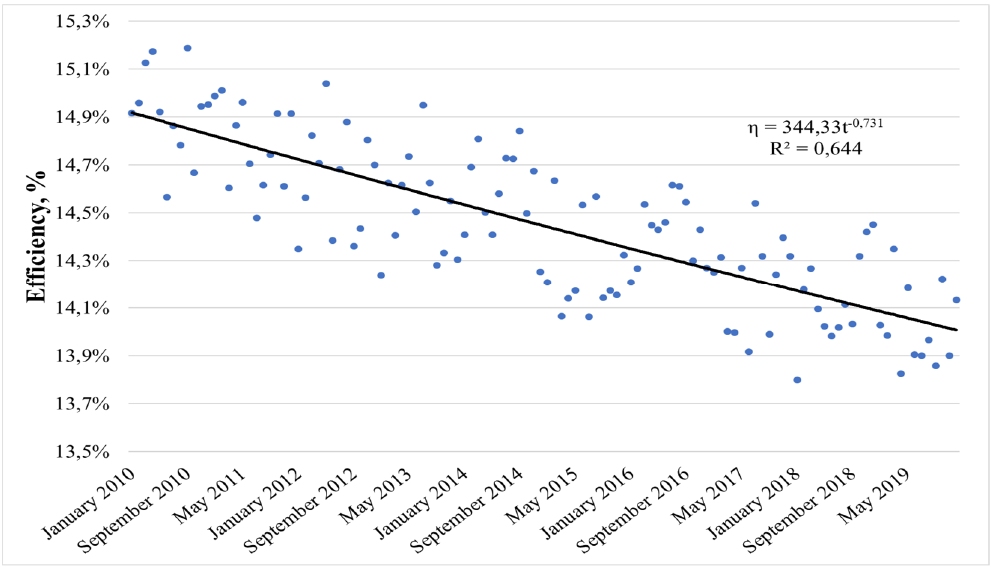
Figure 6. The efficiency of the PV system.